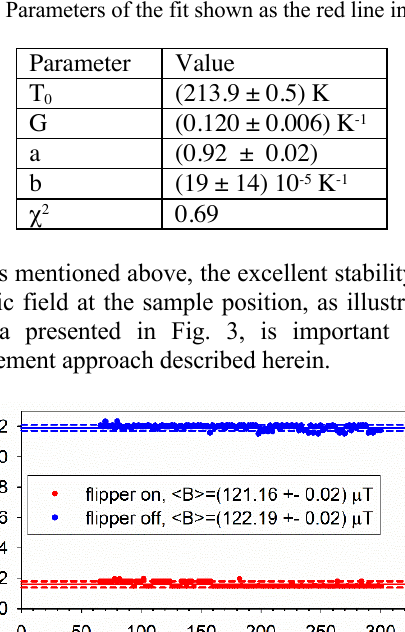
Table 1. Parameters of the fit shown as the red line in Fig. 2.